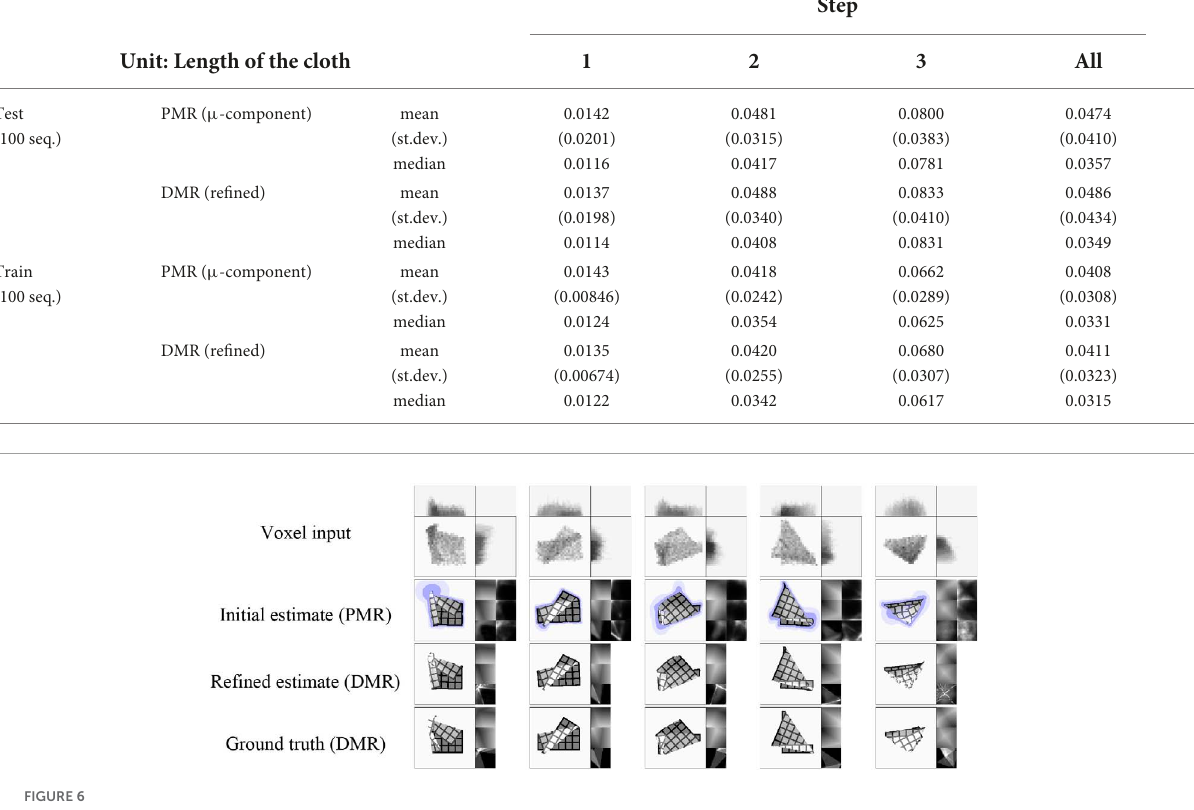
TABLE 2 Mesh estimation accuracy.